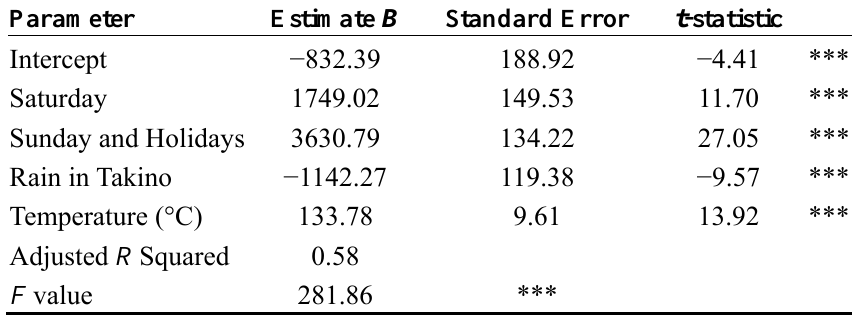
Table 3. Regression analysis for the number of visitors in the green season in fiscal years FY 2002–FY 2005, using day of the week and meteorological parameters.